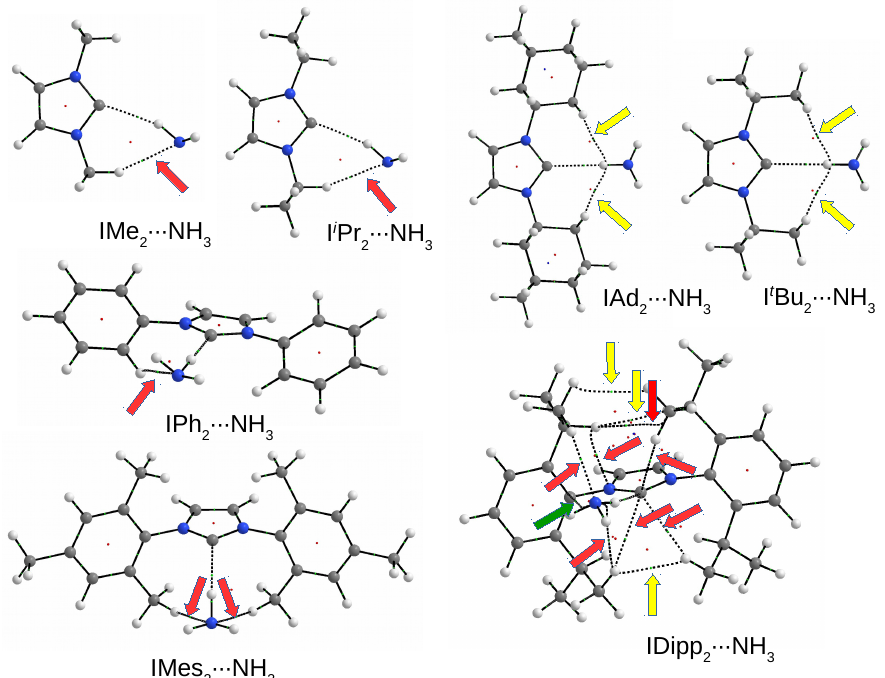
Figure 10. Molecular graphs of the IR 2 · · · NH 3 dimers. Arrows show the presence of bond paths for some accompanying interatomic interactions (hydrogen bonds—red, C-H · · · H-C or C-H · · · H-N contacts—yellow, and N · · · π contact—dark green). Large balls represent atoms (hydrogen—white, carbon—gray, and nitrogen—blue) and small balls represent critical points (bond critical points—light green, ring critical points—red, and cage critical